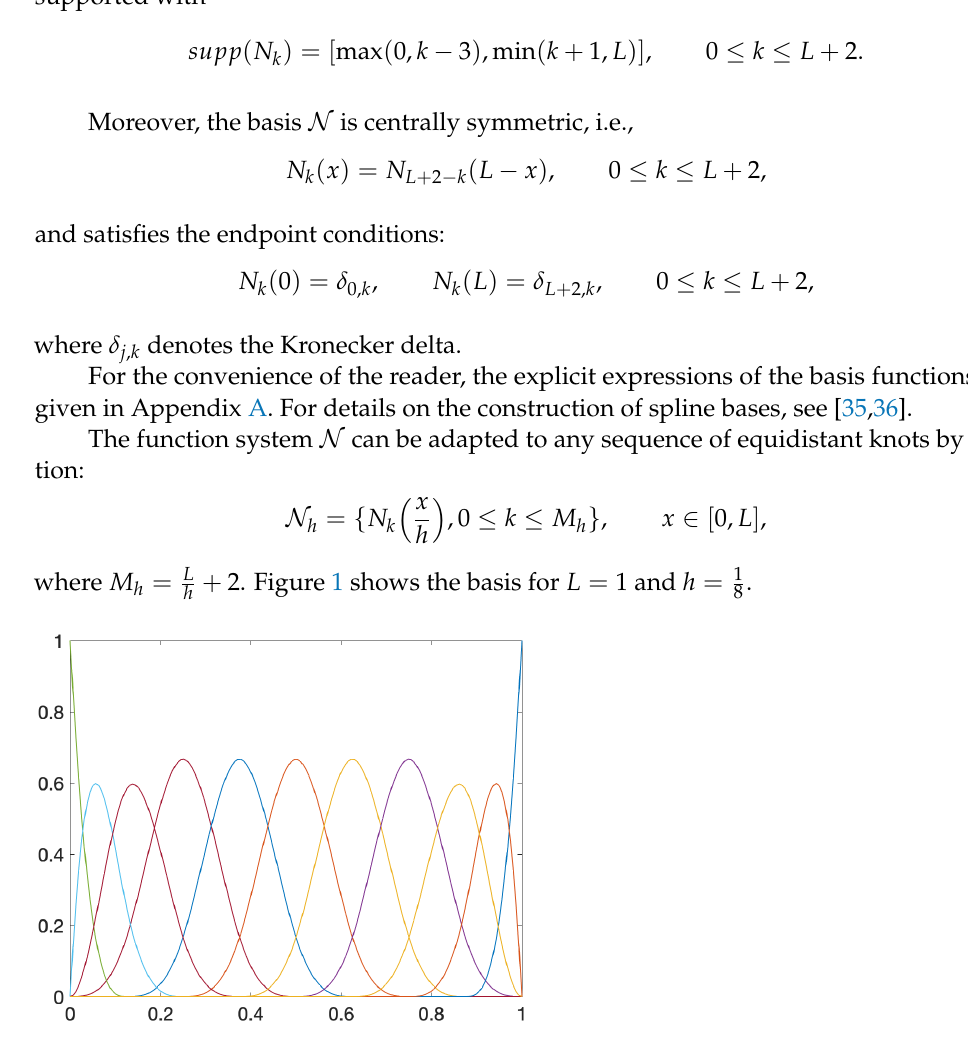
Figure 1. The cubic spline basis N h on the interval [ 0,1 ] with space step h =